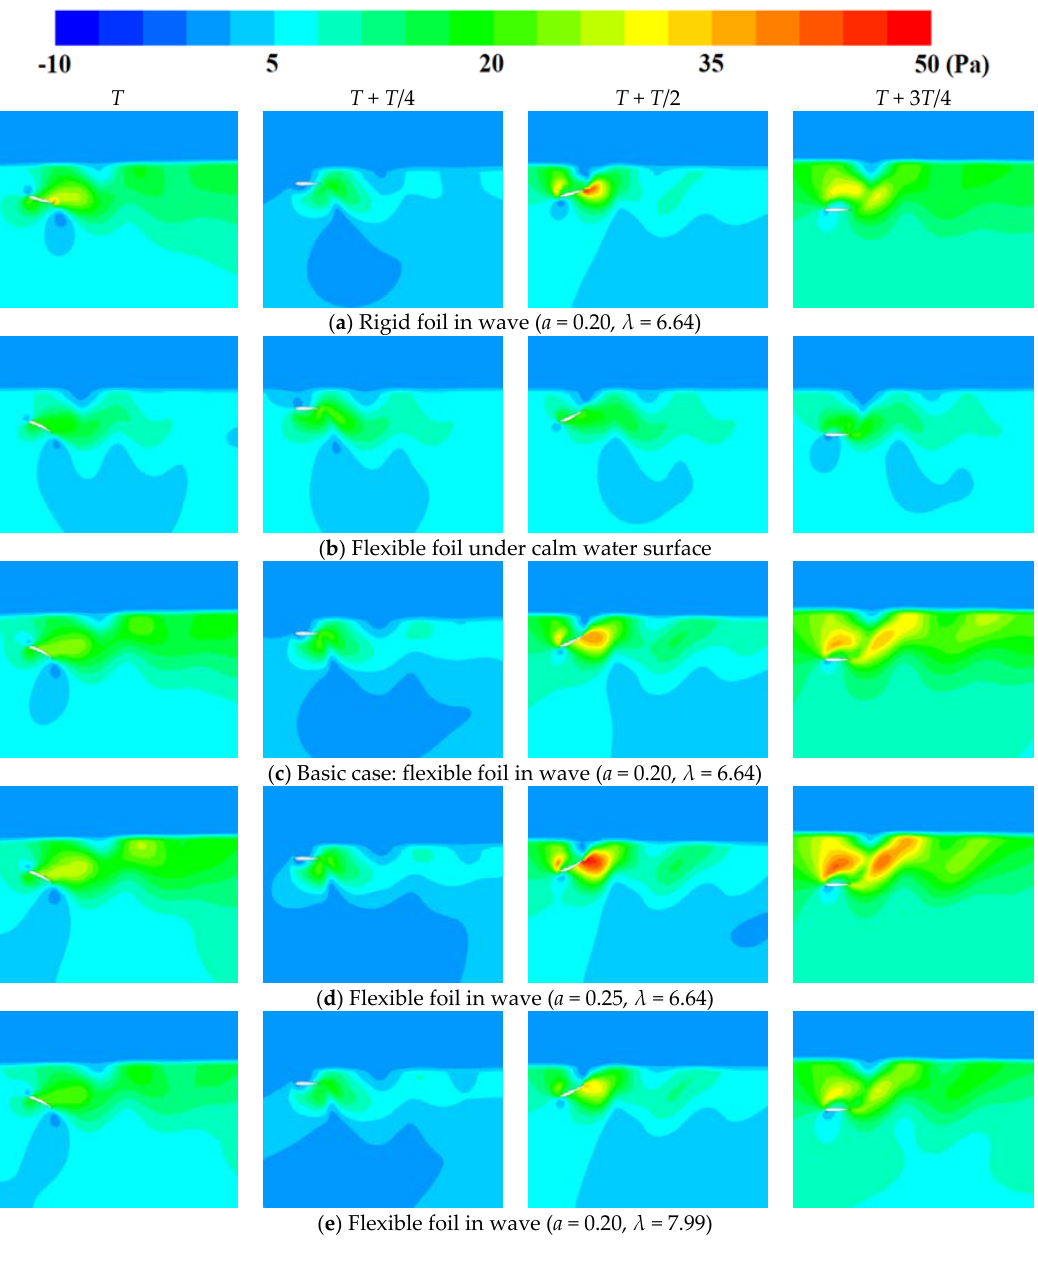
Figure 12. Dynamic pressure distribution for different wave parameters in one period.